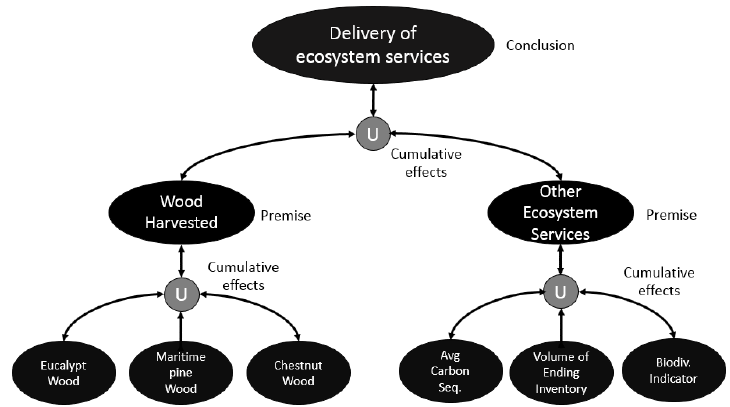
Figure 6. NetWeaver model to assess delivery of ecosystem services for individual stands. Data inputs at the stand level vary by Pareto solution (A–F), so this model is evaluated in EMDS with a separate assessment for each Pareto solution (Figure 7). Each oval represents a logic topic. Gray topics shown at the bottom of the diagram are elementary topics that evaluate data inputs with fuzzy membership functions.